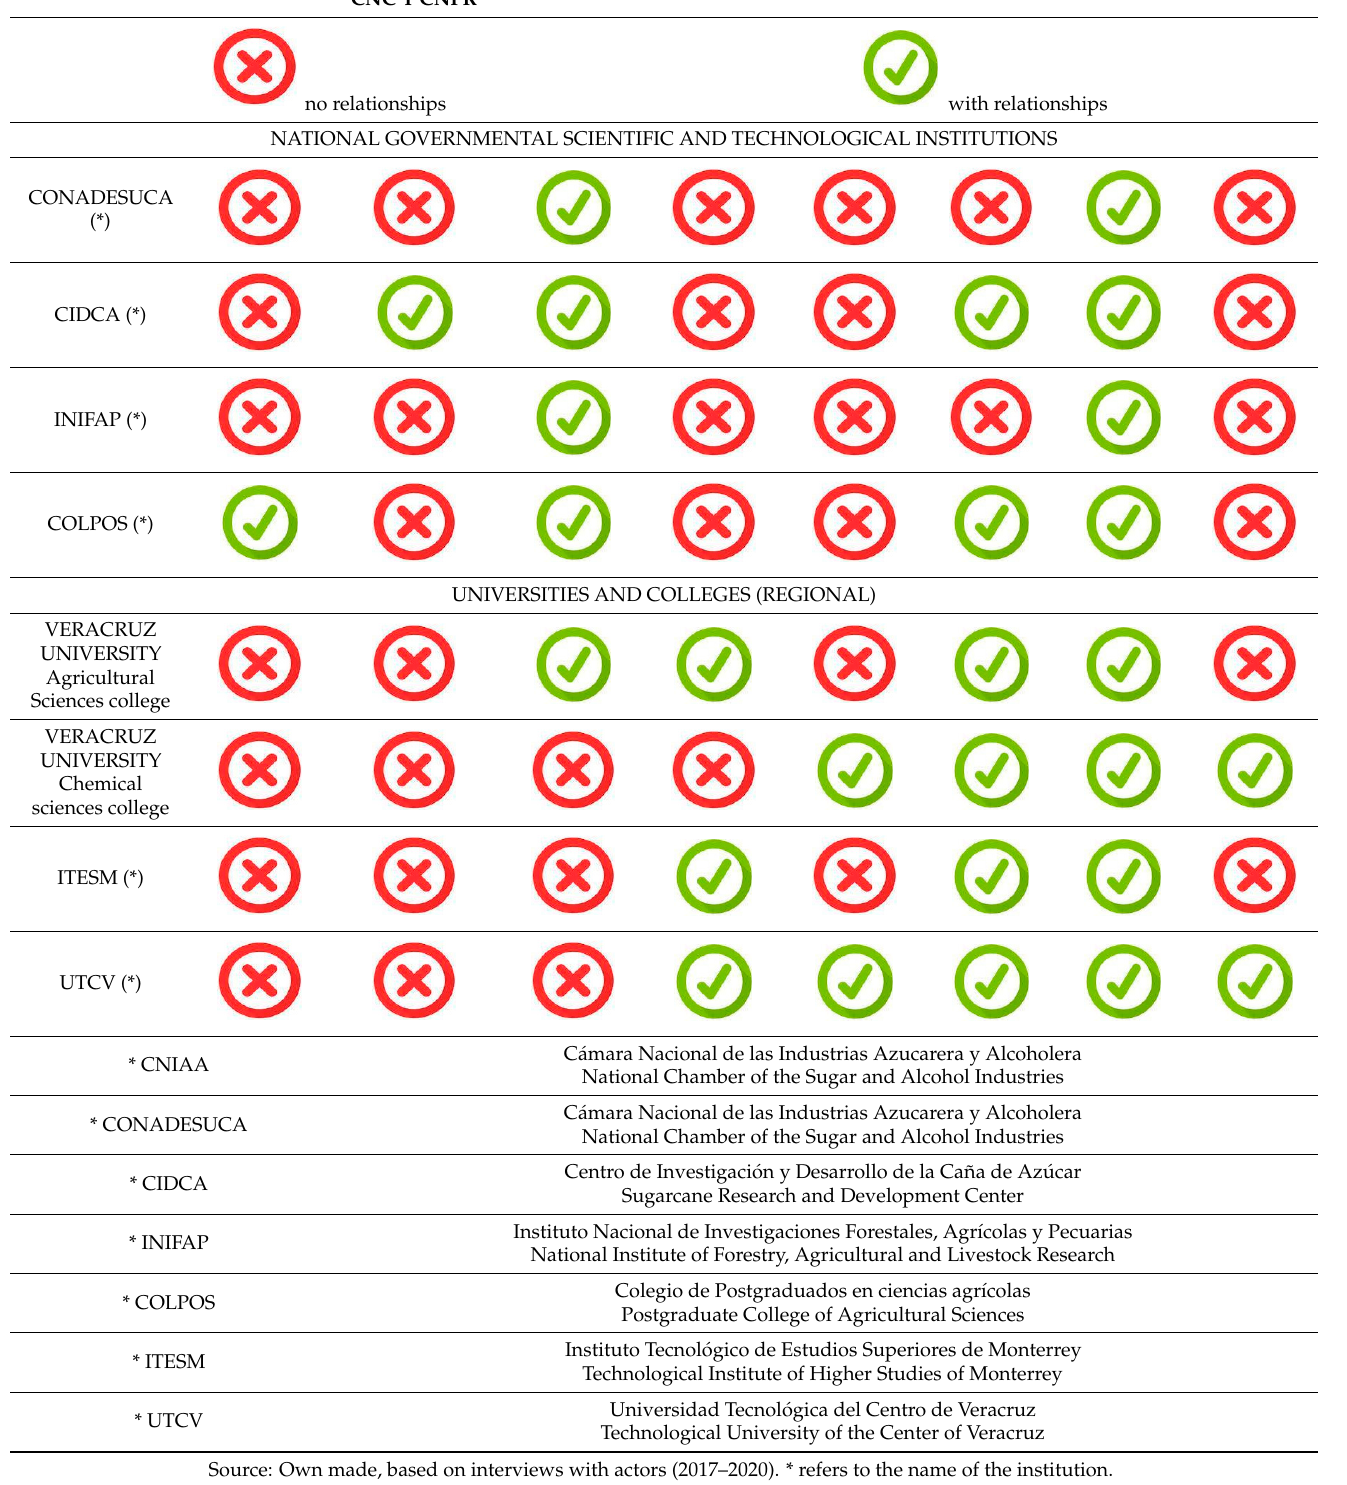
Table 3. Relations of R&D system with the conservative, intermediate and innovative network actors.